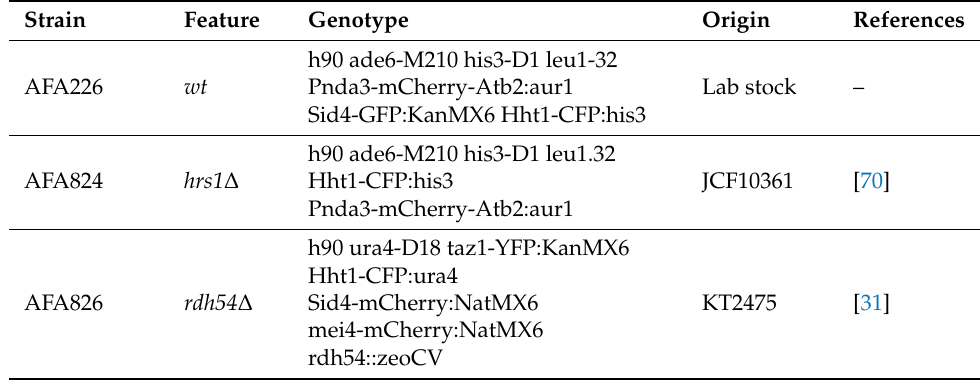
Table A1. Schizosaccharomyces pombe strains used in this